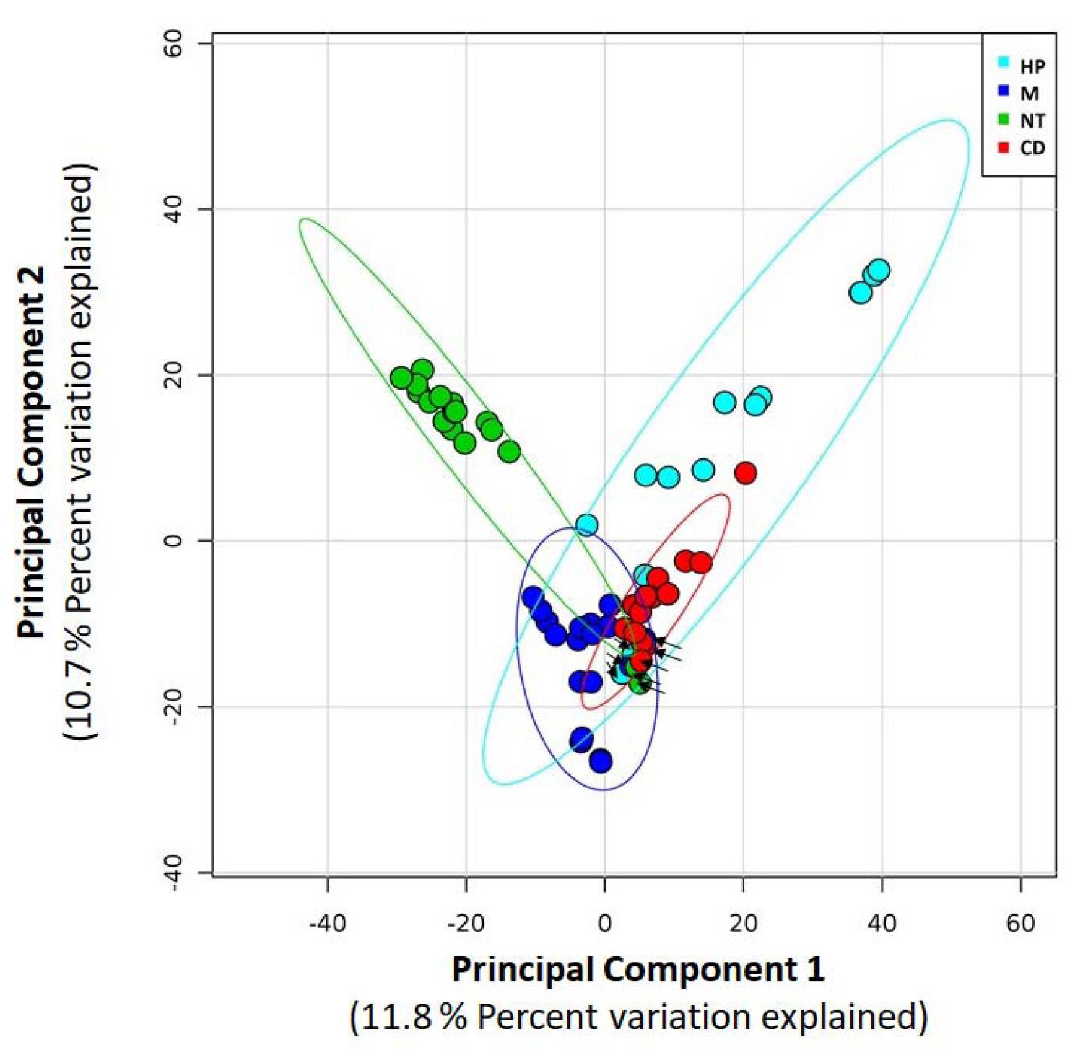
Figure 5. Principal components analysis (PCA) of the normalized relative abundance of 16S rRNA sequences in all samples. Data are plotted following the genus-level classification. Light blue dots for network with hydrogen peroxide (HP), blue for monochloramine (M), red for chlorine dioxide (CD), and green for not chemically treated (NT). Black arrows indicate inlet cold water samples for each network.